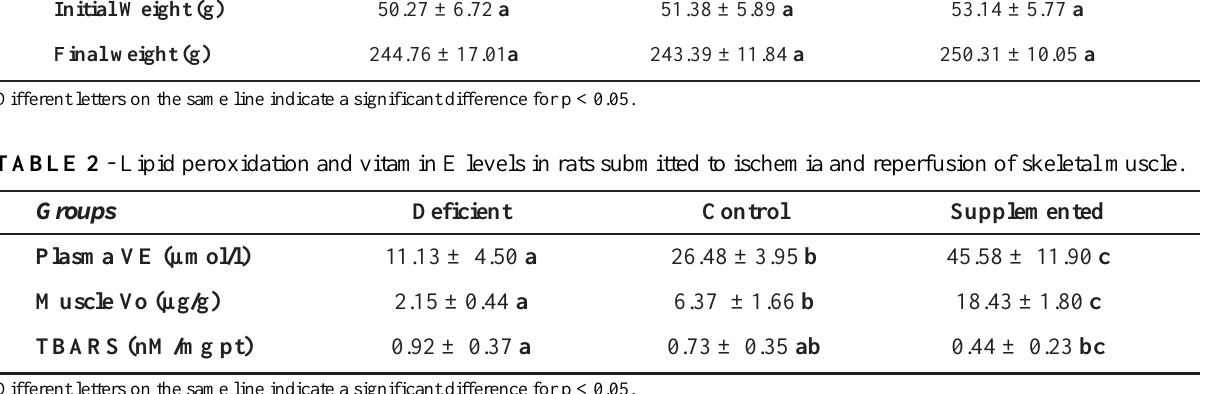
Different letters on the same line indicate a significant difference for p <